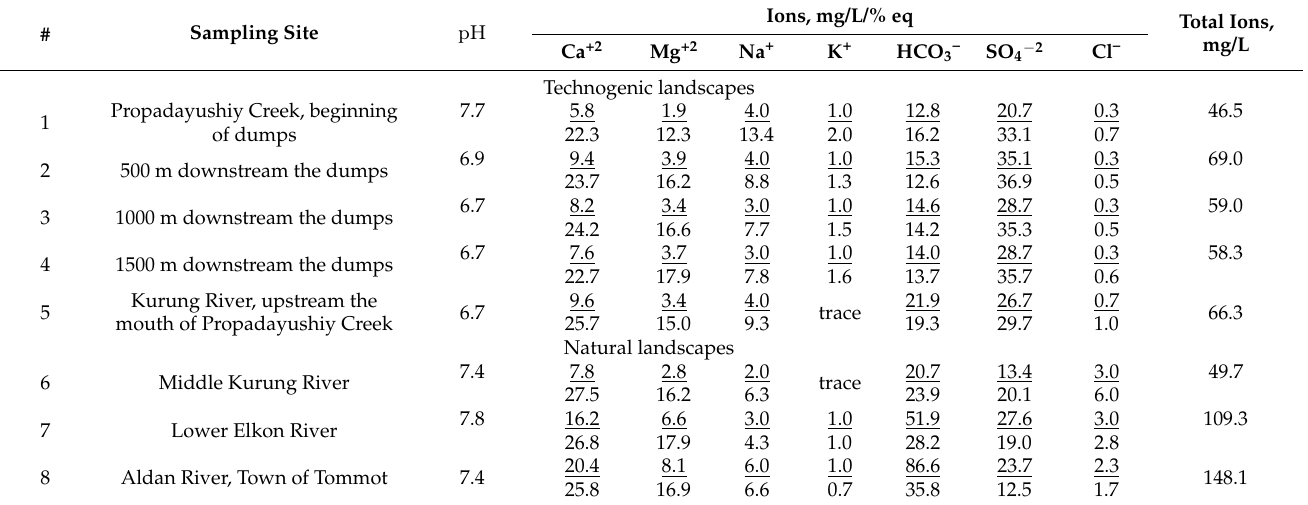
Table 3. Ionic composition of surface waters of technogenic and natural landscapes of Southern